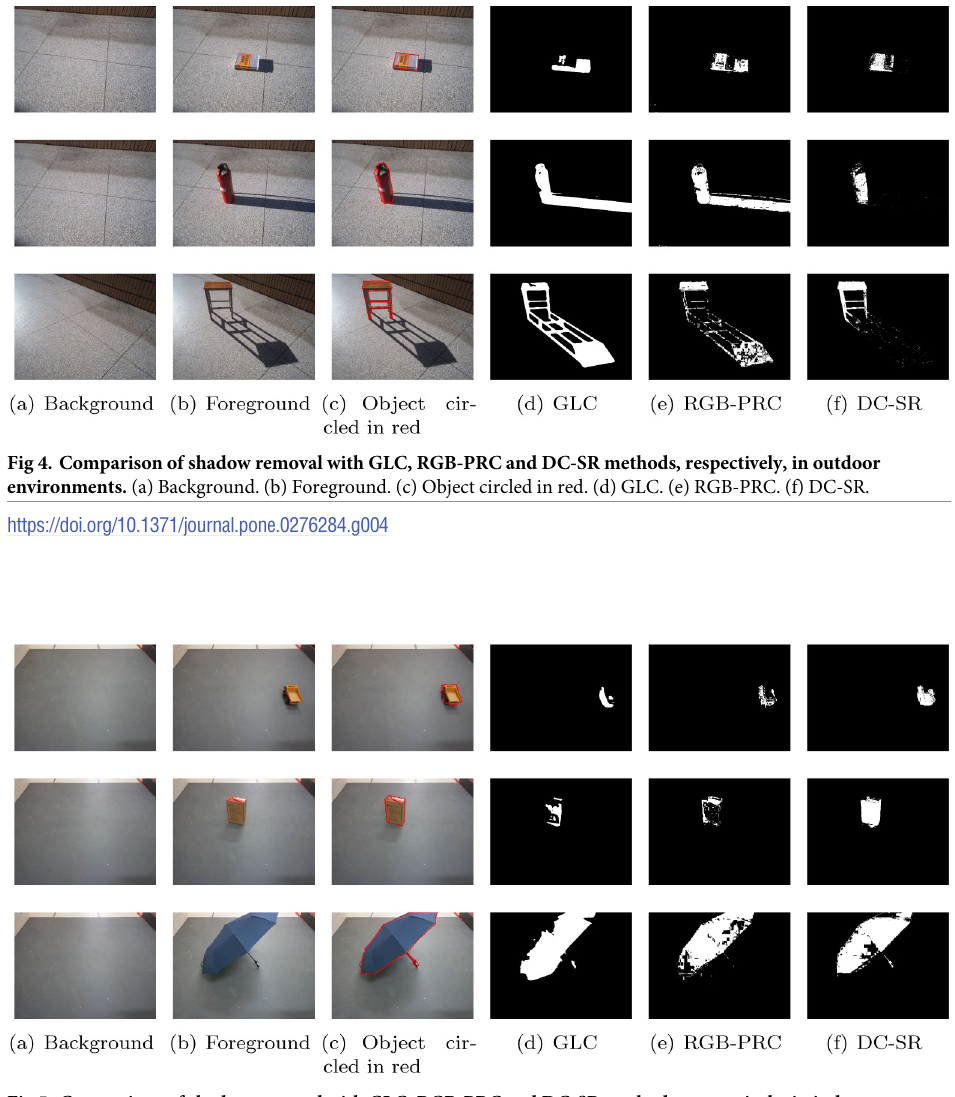
PLOS ONE | https://doi.org/10.1371/journal.pone.0276284 February 7,